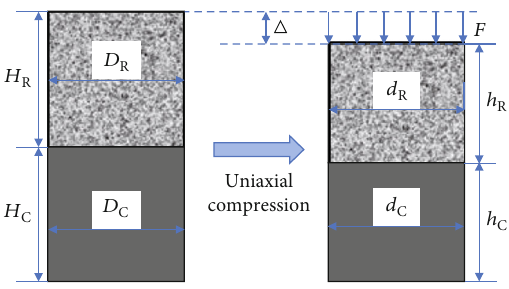
Figure 5: Schematic diagram of the deformation of the coal – rock combination under an external